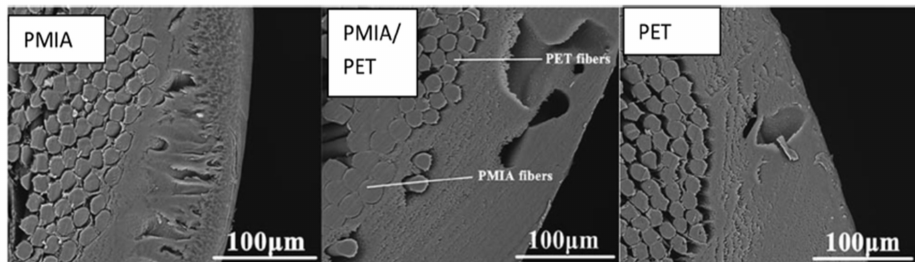
Figure 24. Scanning electron microscopy (SEM) images of PMIA braid, PMIA/PET braid and PET braid [228]. Reprinted/adapted with permission from Ref. [228]. Copyright 2022, Royal Society of